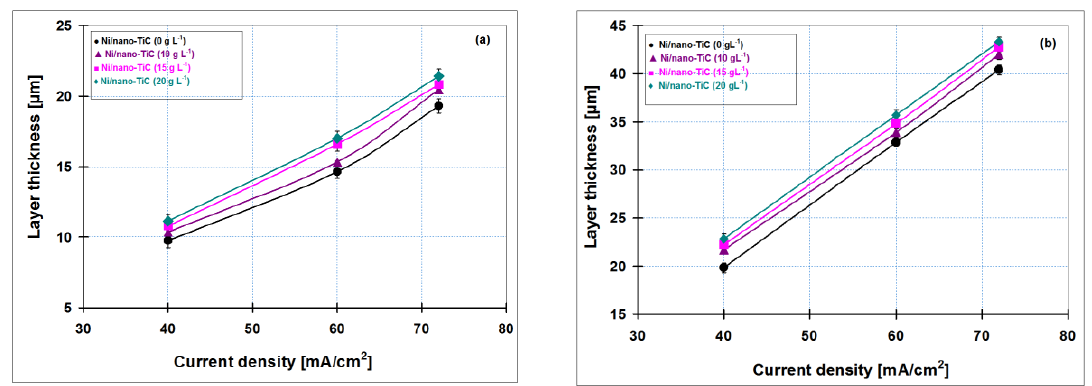
Figure 12. Layer thickness variation depending on the current density by weighting and SEM in cross section of layers of pure Ni and Ni/nano-TiC (10, 15 and 20 g · L −1 ) at the codeposition time of: ( a ) 15 min; and ( b ) 30 min.